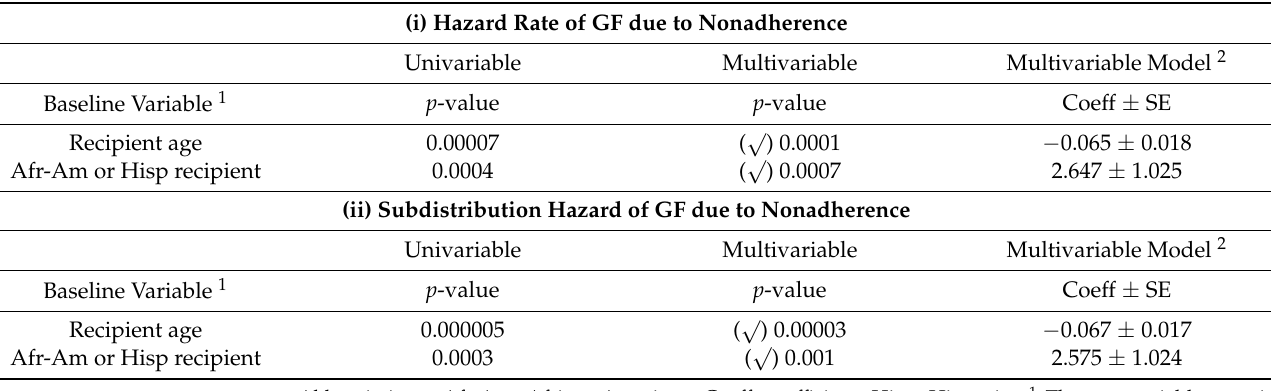
Table 3. Cox model results for the: (i) hazard rate of developing GF due to nonadherence, and (ii) sub- distribution hazard of GF due to nonadherence (22 events each).